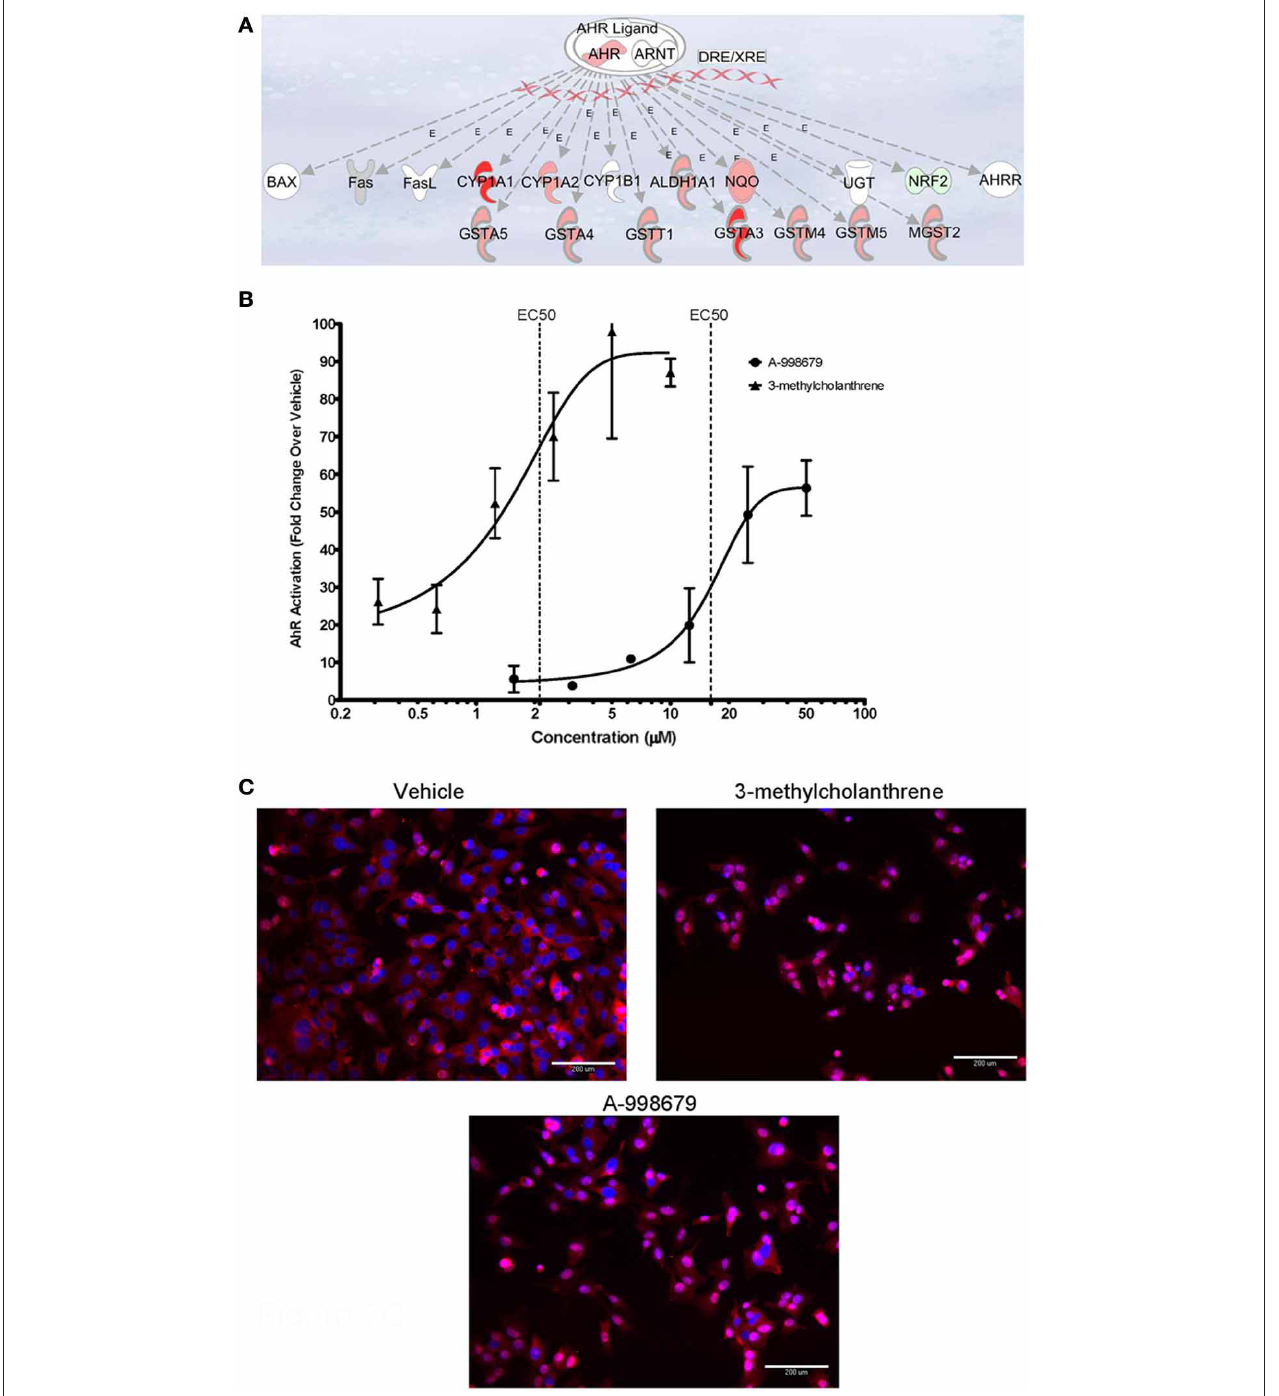
FIGURE 7 | (A) Representation of genes induced upon activation of AhR and its subsequent binding to the DRE. Genes displayed as shades of red were increased in mRNA expression, while those in shades of green were decreased. Genes colored in white were not differentially regulated. (B) Luciferase gene reporter assay correlating to the degree of AhR activation in HepG2 cells. The concentration of A-998679 or the positive control (3MC) is displayed on the x-axis. Activation of AhR (average fold change ± SD) is indicated on the y-axis. (C) Representative